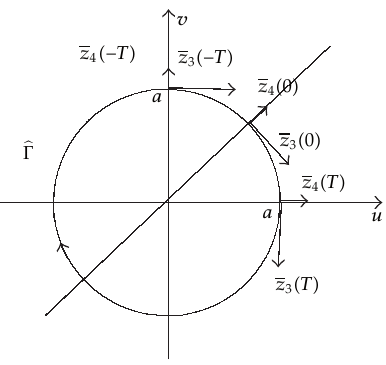
Figure 1: The geometry of vectors on the center